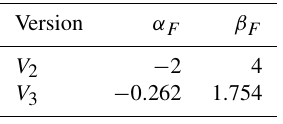
Table 4. Parameters of the modified gamma shape used to approxi- mate the normalized PSD.